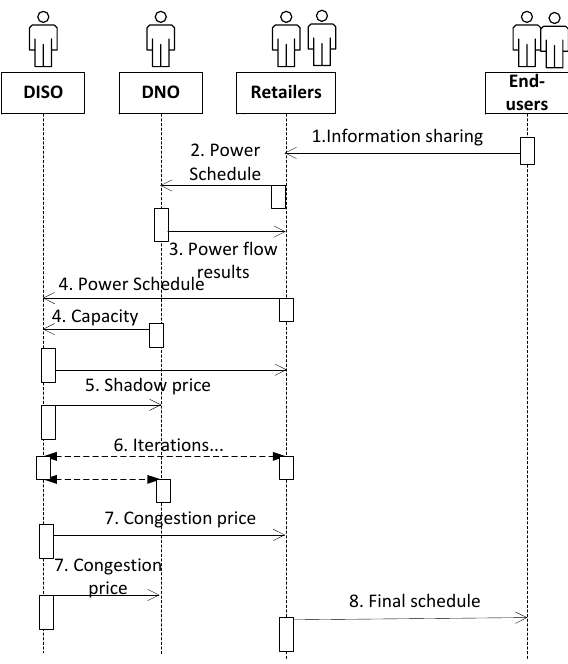
Figure 2. Overall operational sequence diagram of the transactive distribution system. DISO: distribution-independent system